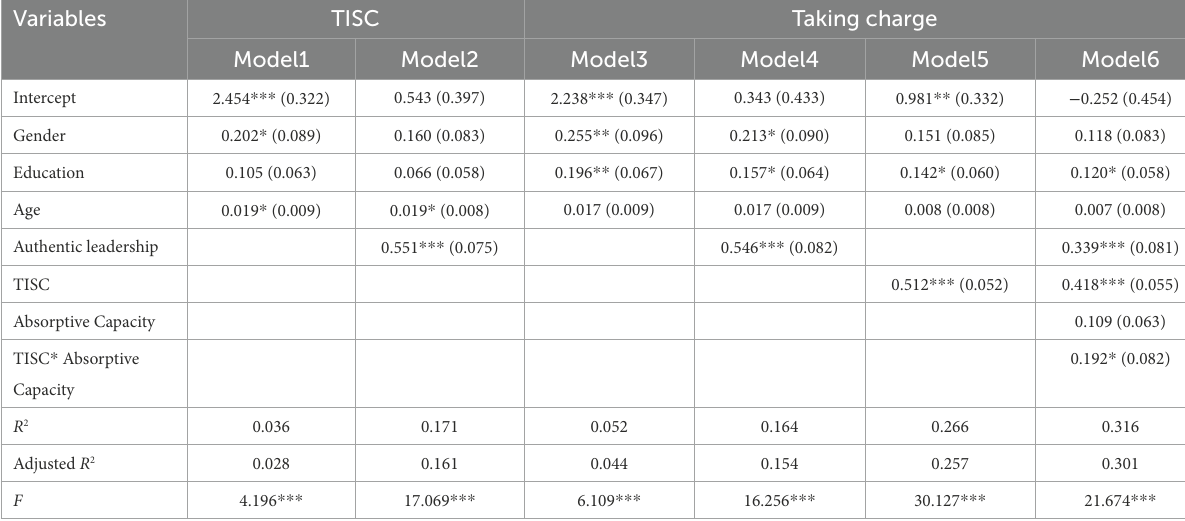
TABLE 3 Linear regression